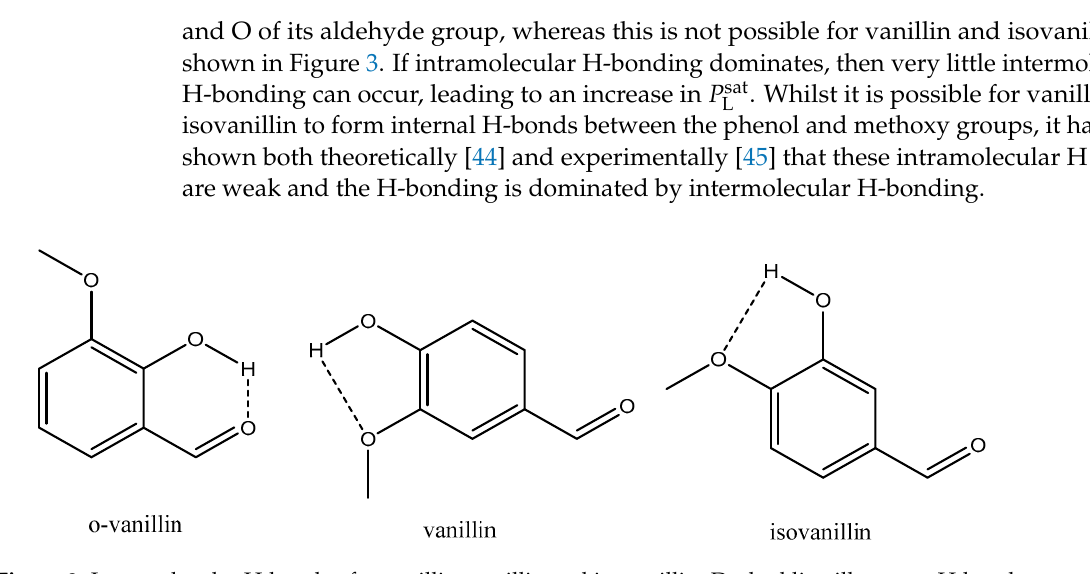
10 of 17 Figure 2. (cid:1842) (cid:2896)(cid:2929)(cid:2911)(cid:2930) vs. partial charge of the phenolic/carboxylic carbon for the compounds capable of H-bonding. Error bars are ± 75%.